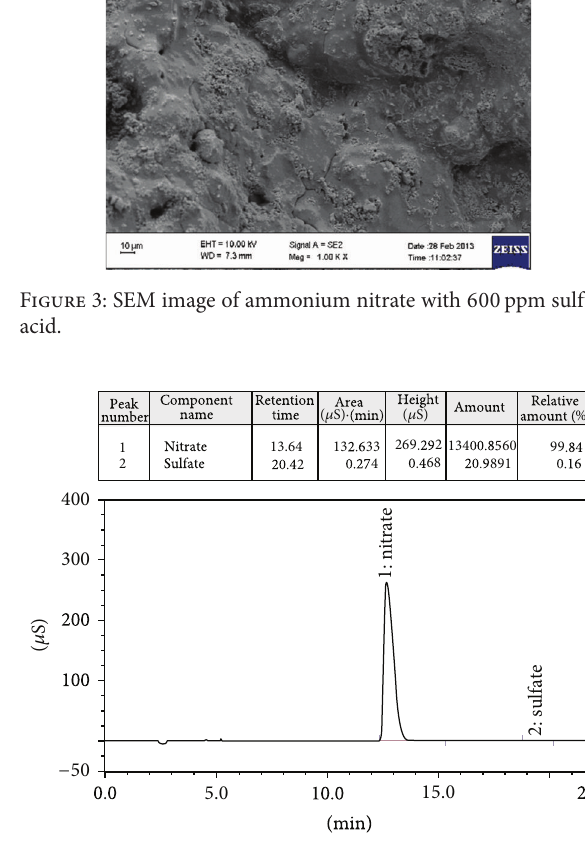
Figure 4: Ion chromatography for ammonium nitrate with 1mL H 4 SiO 4 /5.6 mL H 2 SO 4